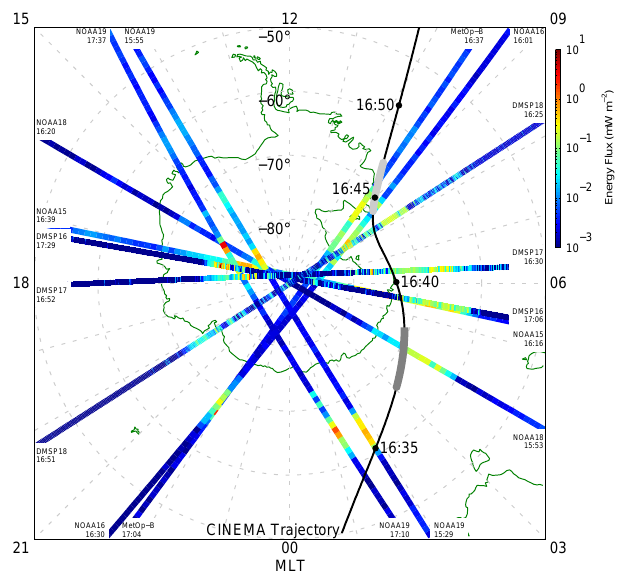
Figure 8. Polar map of the magnetic South Pole in geomagnetic coordinates. CINEMA’s trajectory is shown in black, with the two periods of field-aligned currents shown in Fig. 7 highlighted. Total energy fluxes measured by the DMSP (electrons only) and POES (ions and electrons) within ± 45min of the CINEMA crossing are also